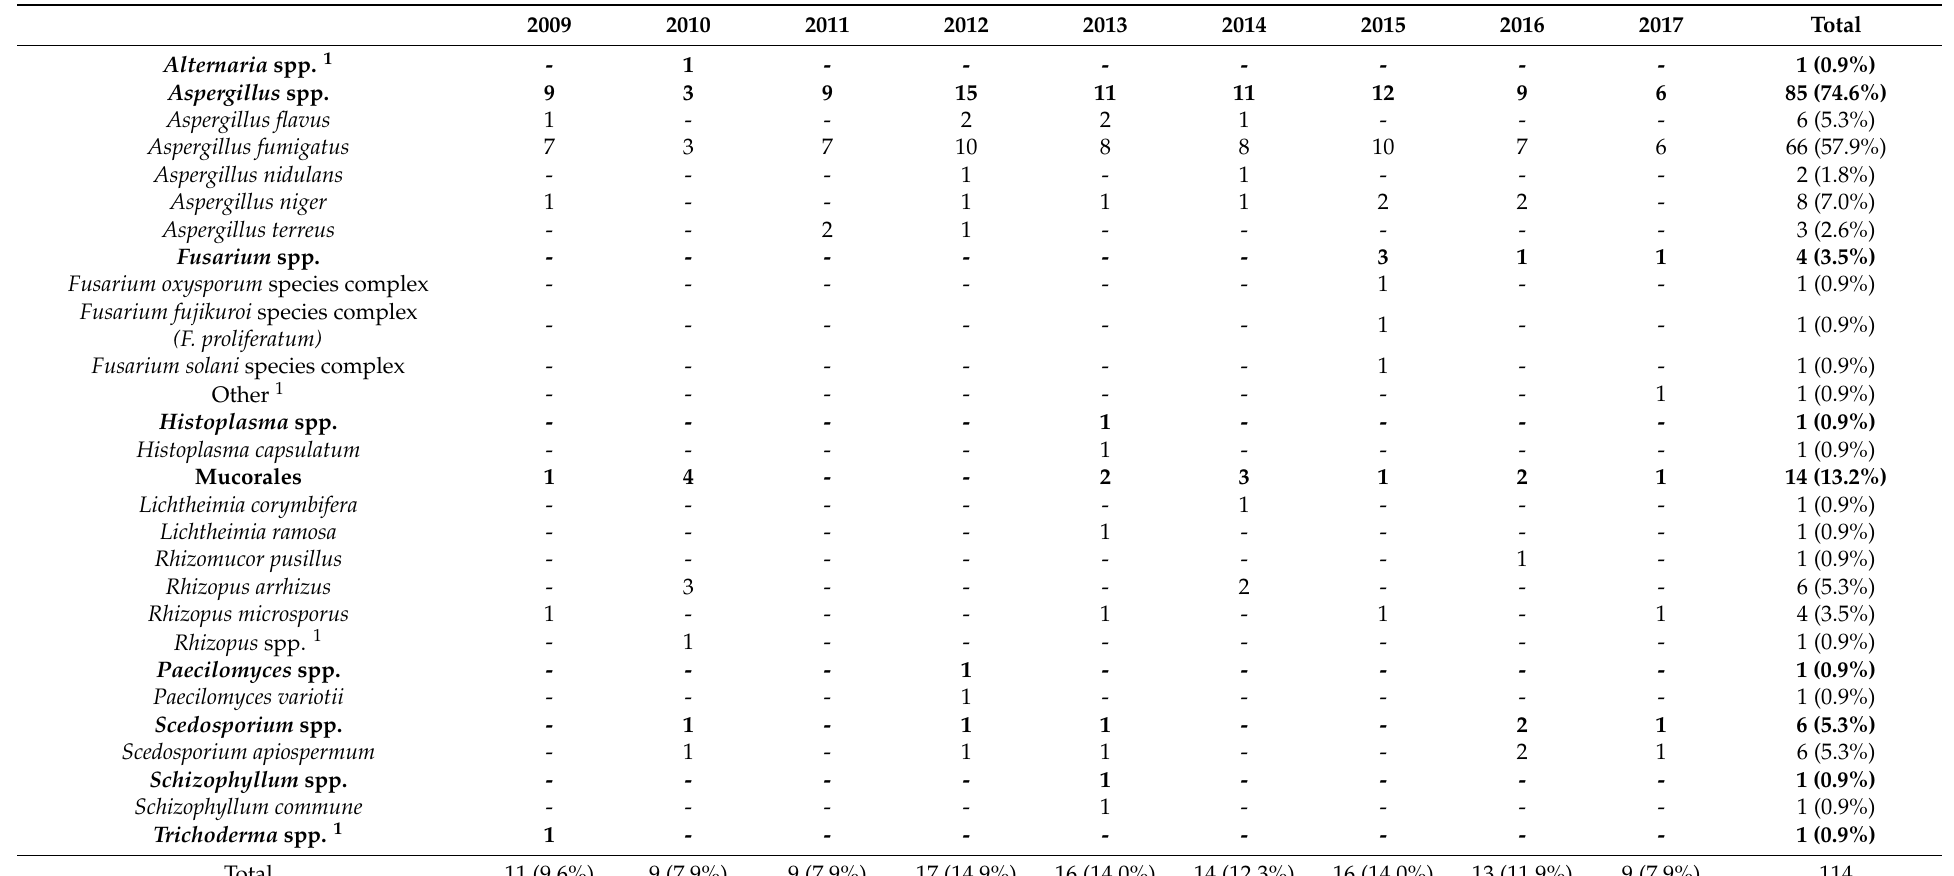
Table A1. Spectrum of isolated filamentous fungi in probable or proven infections per year.